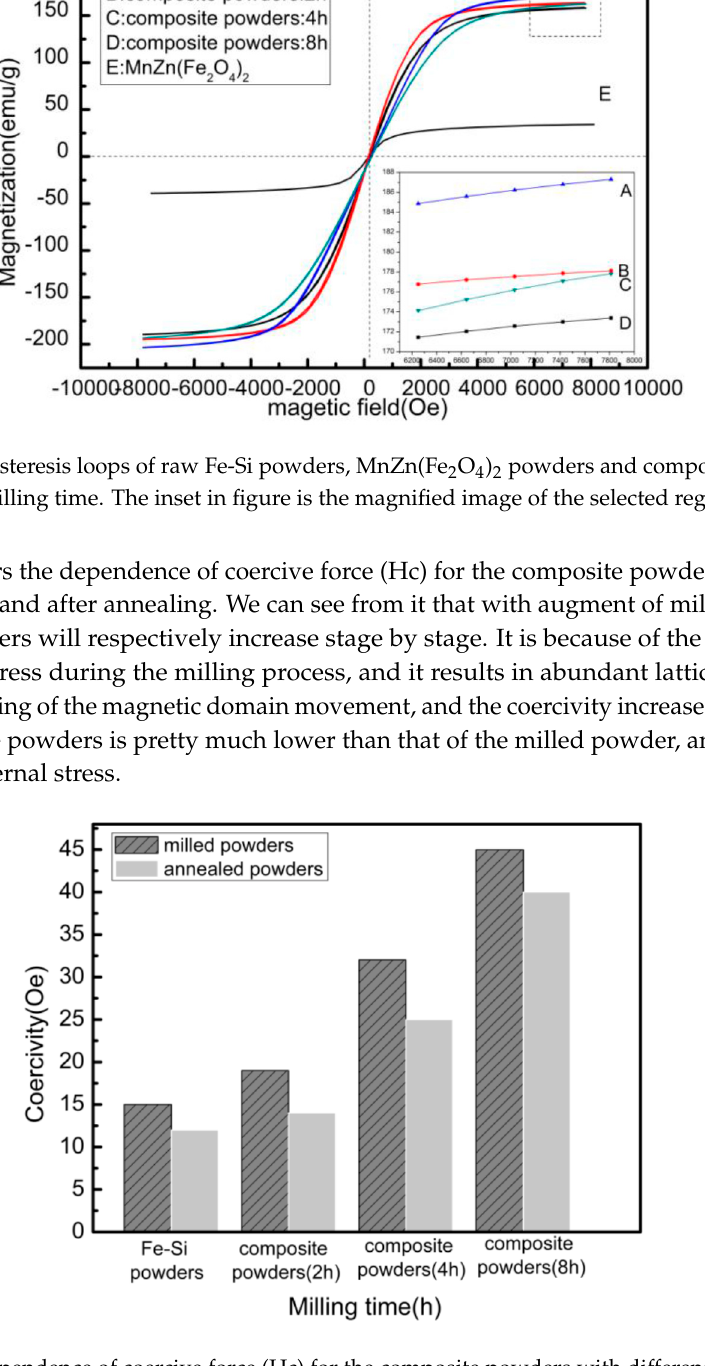
Figure 8. The dependence of coercive force (Hc) for the composite powders with different milling time before and after annealing in argon atmosphere.